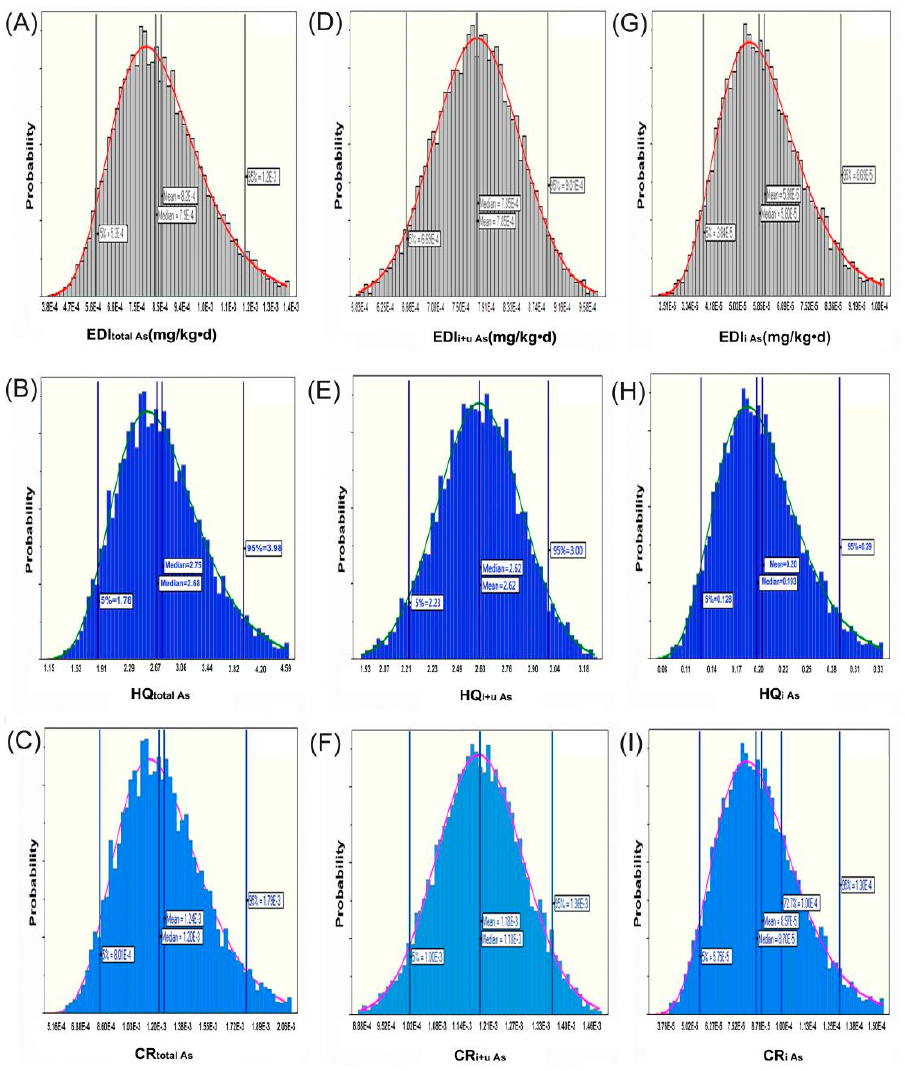
Figure 6. Estimated distribution patterns and descriptive statistics of ( A , D , G ) estimated daily intake ( EDI ), ( B , E , H ) hazard quotient ( HQ ), and ( C , F , I ) cancer risk ( CR ). Where in ( A – C ) values were derived according to the total As concentration in O. sinensis ; in ( D – F ) values were derived according to the i+uAs concentration (the sum of iAs and uAs) in O. sinensis ; and in ( G – I ) values were derived according to the iAs concentration in O. sinensis .